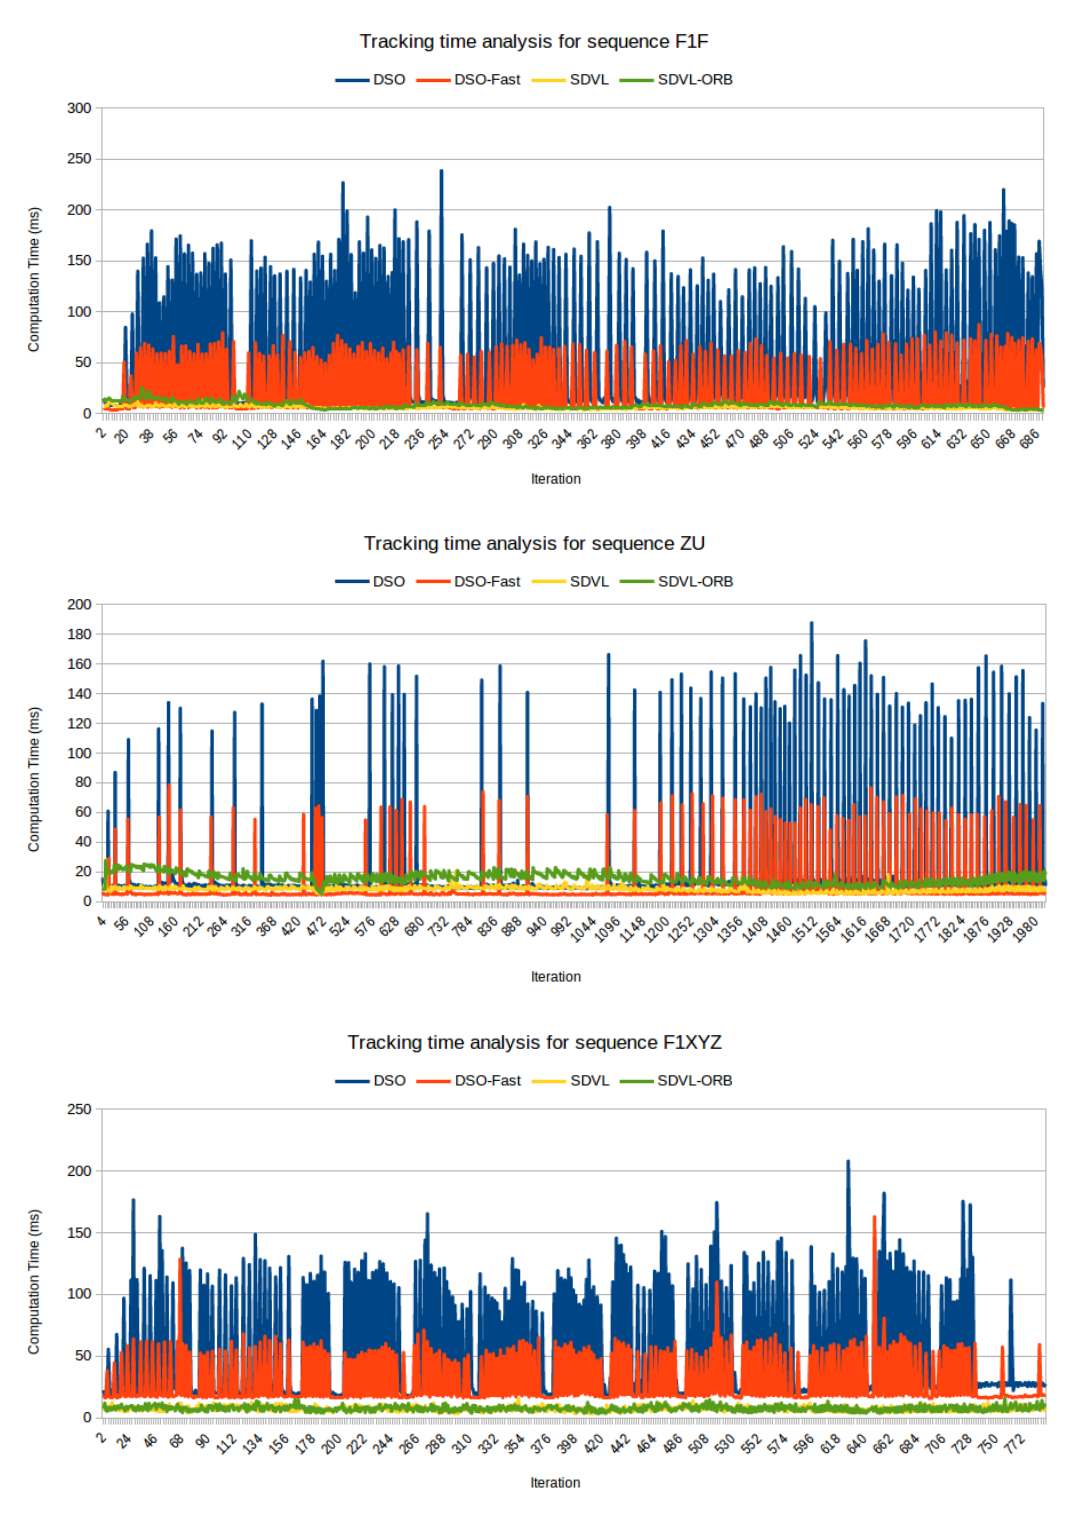
Figure 10. Tracking time evolution for F1F sequence, ZU sequence (first 2000 iterations) and F1XYZ